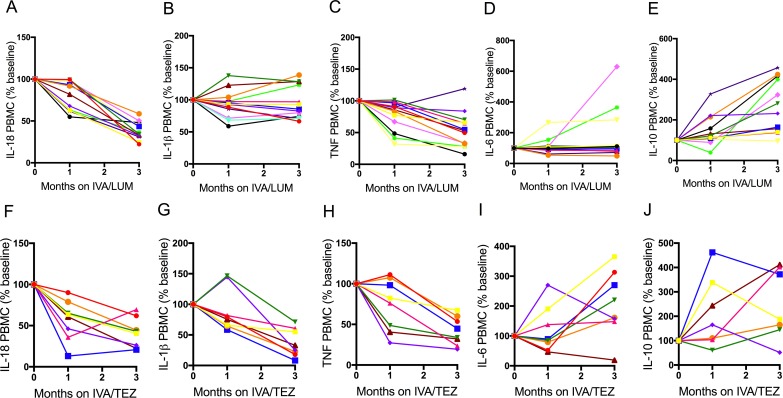
Individual therapy PBMC cytokine response in NLRP3- stimulated CF immune cells isolated from patients with CF (homozygous Phe508del) following treatment with IVA/LUM or IVA/TEZ.PBMCs isolated at baseline, one month and three months from patients homozygous for Phe508del CFTR mutations receiving compassionate use IVA/LUM (n = 12/13) or IVA/TEZ (n = 8) therapy. Following isolation, PBMCs were immediately stimulated with LPS (10 ng/mL, 4 hr), and ATP (5 mM) for the final 30 min. ELISA assays were used to detect levels of A, IL-18; B, IL-1β; C, TNF; D, IL-6 and E, IL-10 secretion from PBMCs in the IVA/LUM treated group. ELISA assays were used to detect levels of F, IL-18; G, IL-1β; H,TNF; I, IL-6; J, IL-10 secretion from PBMCs in the IVA/TEZ treated group. Baseline for each patient set at 100% and proportional change at one and three months plotted. For IVA/LUM: IL-18 (n = 13); IL-1β (n = 13); TNF (n = 12); IL-6 (n = 13); IL-10 (n = 12).